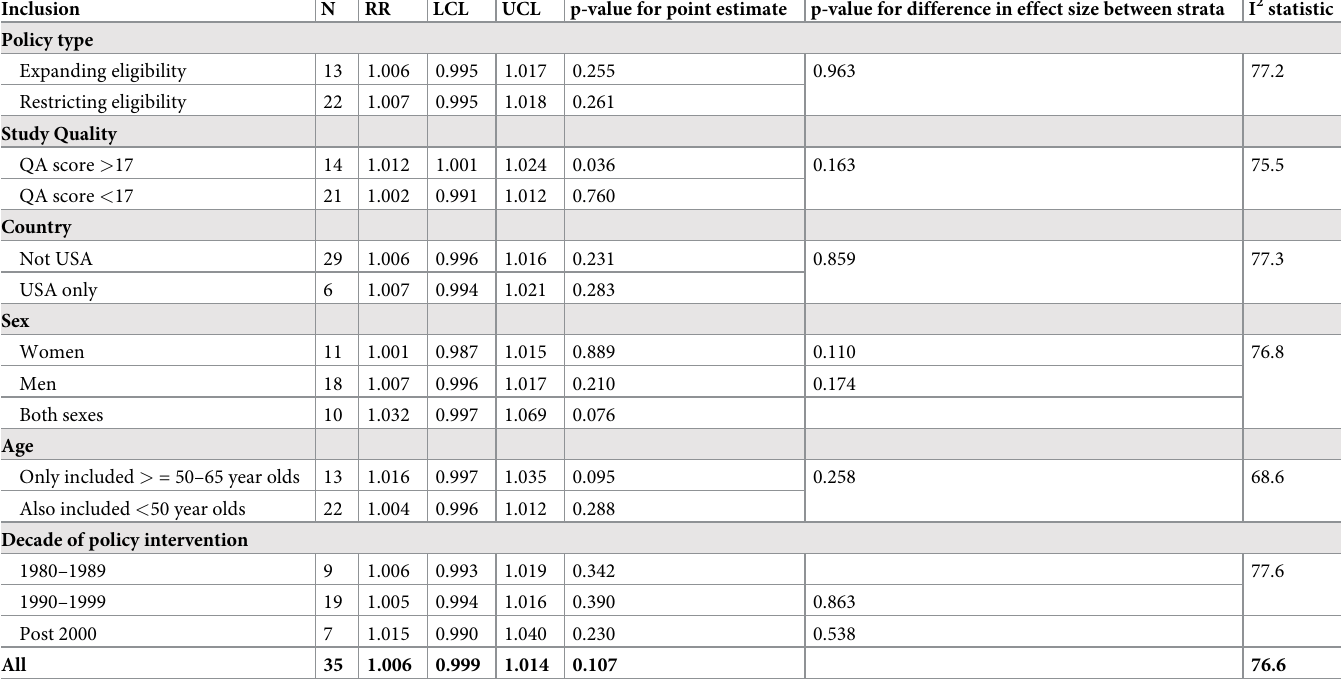
Table 3. Pooled risk ratio estimates, from meta-regressions, showing the relative increase in employment associated with policy implementation for sub-groups of studies and overall effect.